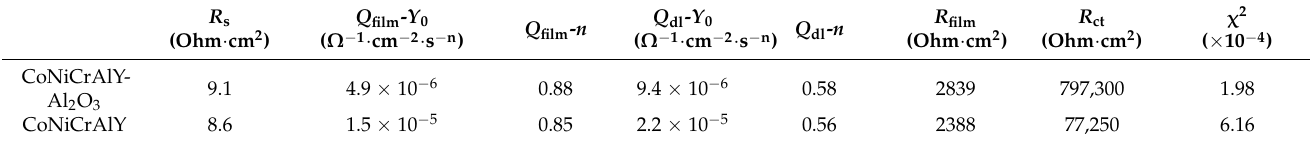
Table 7. Electrochemical parameters obtained from electrochemical impedance spectroscopy of coatings.